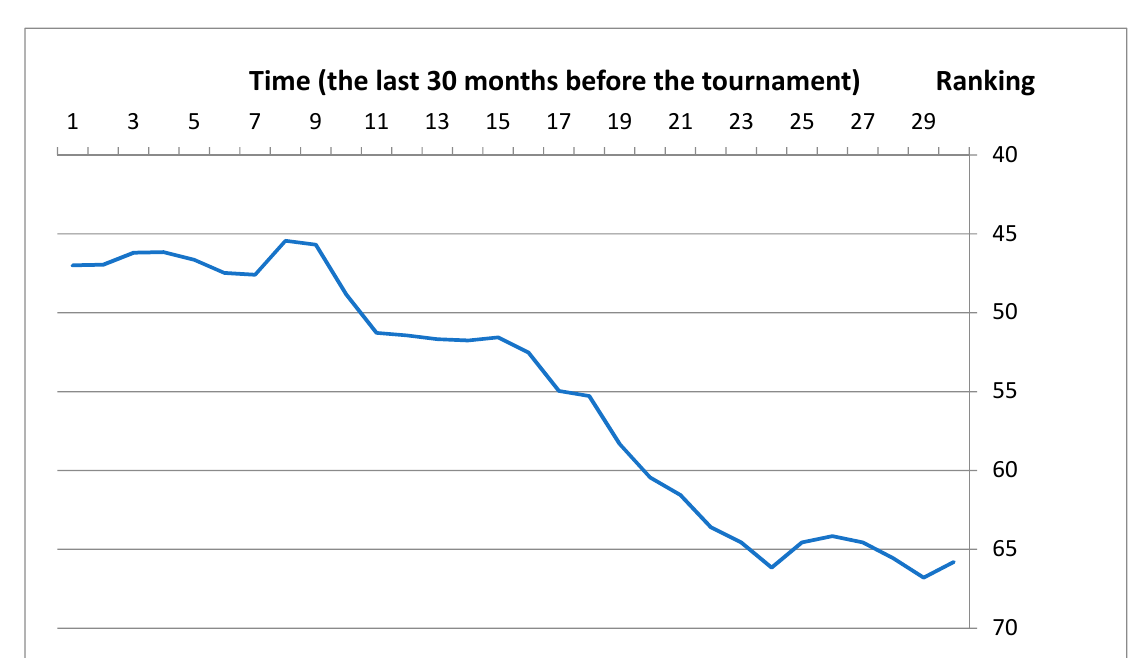
Figure 3. Average downward slide of 26 tournament hosts over the 30 months preceding the tournament in the FIFA rankings. Note: Y -axis: Position in the rankings; X -axis: Subsequent months, starting 30 months before the